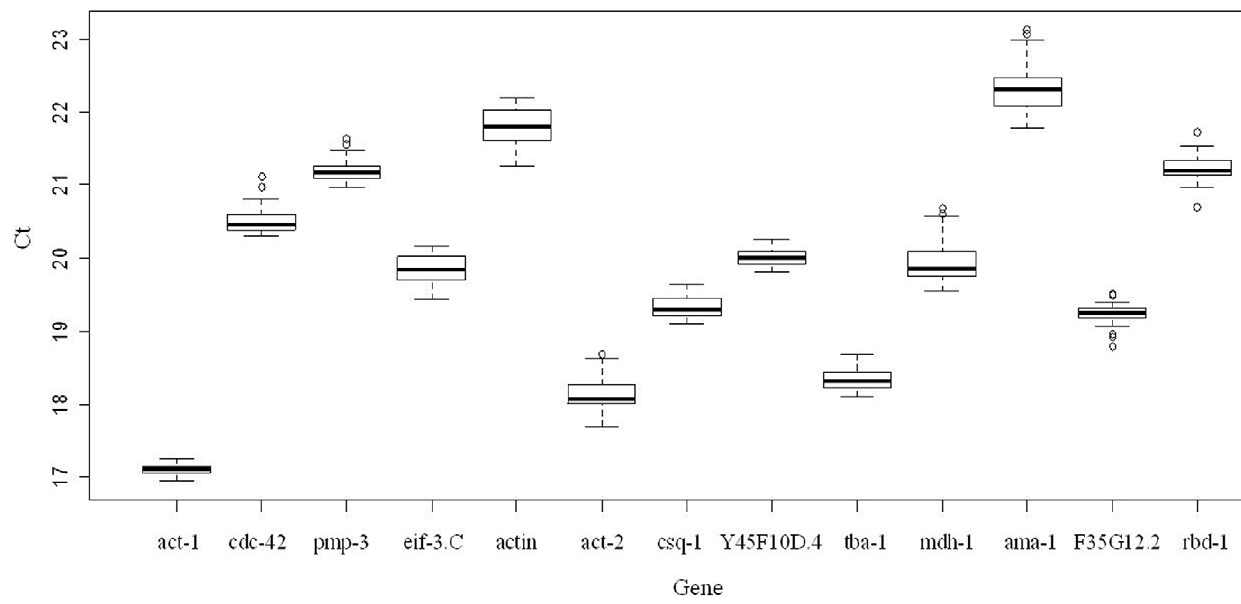
Figure 1. Distribution of threshold cycle (Ct) values for candidate reference genes obtained using qPCR in C.elegans . Boxes show the range of Ct values within each candidate gene; the black centre line indicates the median Ct; the extended upper and lower hinges indicate 75 and 25 percentiles; the whiskers show the largest/smallest Ct values that falls within a distance of 1.5 times IQR (Interquartile range) from the upper and lower hinges; outliers are shown as small